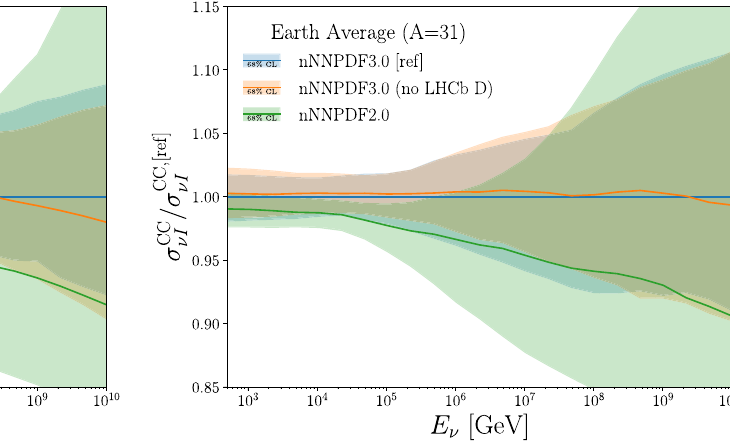
(left) and A = 31 (right), and the uncertainty bands represent the nPDF 68% CL intervals. Each prediction is shown normalised with respect to the nNNPDF3.0 central